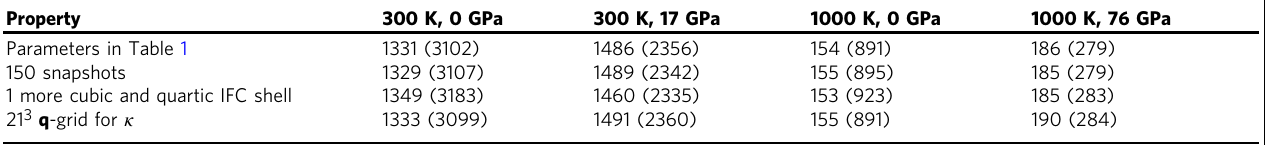
Table 2 Convergence of the thermal conductivity of isotopically pure BAs Property 300 K, 0 GPa Parameters in Table 1 1331